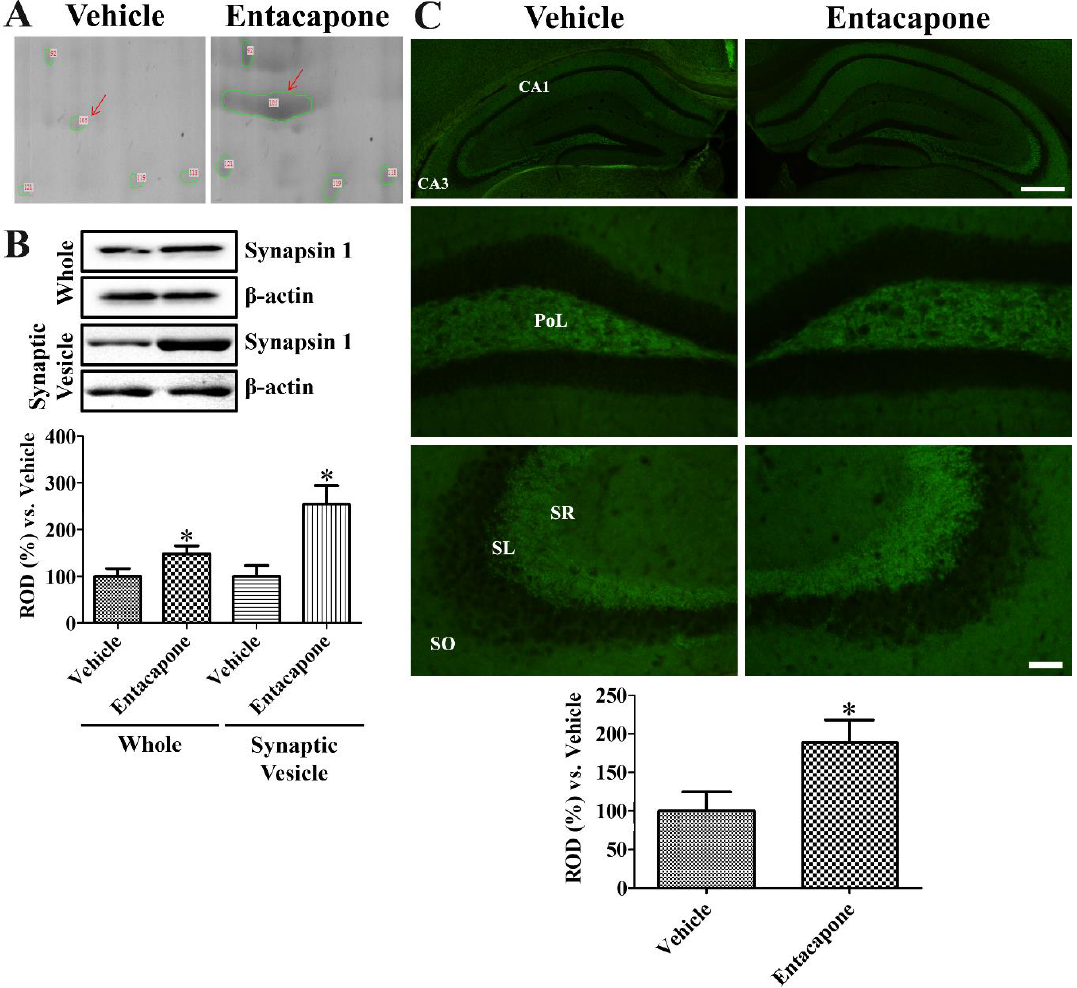
Figure 3. Synapsin I expression in the hippocampus of vehicle- and entacapone-treated groups based on proteomic ( A ), western blot ( B ), and immunohistochemical ( C ) study. Synapsin I spots were detected in proteomic gels and synapsin I protein levels are significantly increased in the hippocampus from whole and synaptic vesicle fractions. Western blot assays were performed in at least triplicate and bar graph represents the mean ± standard deviation. Synapsin I immunoreactivity is detected in the polymorphic layer (PoL) of dentate gyrus and stratum lucidum (SL) of CA3 region. Scale bar = 400 μm (low magnification), 50 μm (high magnification). Three sections , 150 μm apart, are selected between 1.7 and 2.3 mm caudal to the bregma in each animal. Relative optical densities (ROD) are expressed as a percentage of the value of synapsin I protein levels and immunoreactivity in the vehicle-treated group ( n = 5 in each group; * p < 0.05, significantly different from the vehicle-treated group). The bars indicate the mean values ± standard deviation.